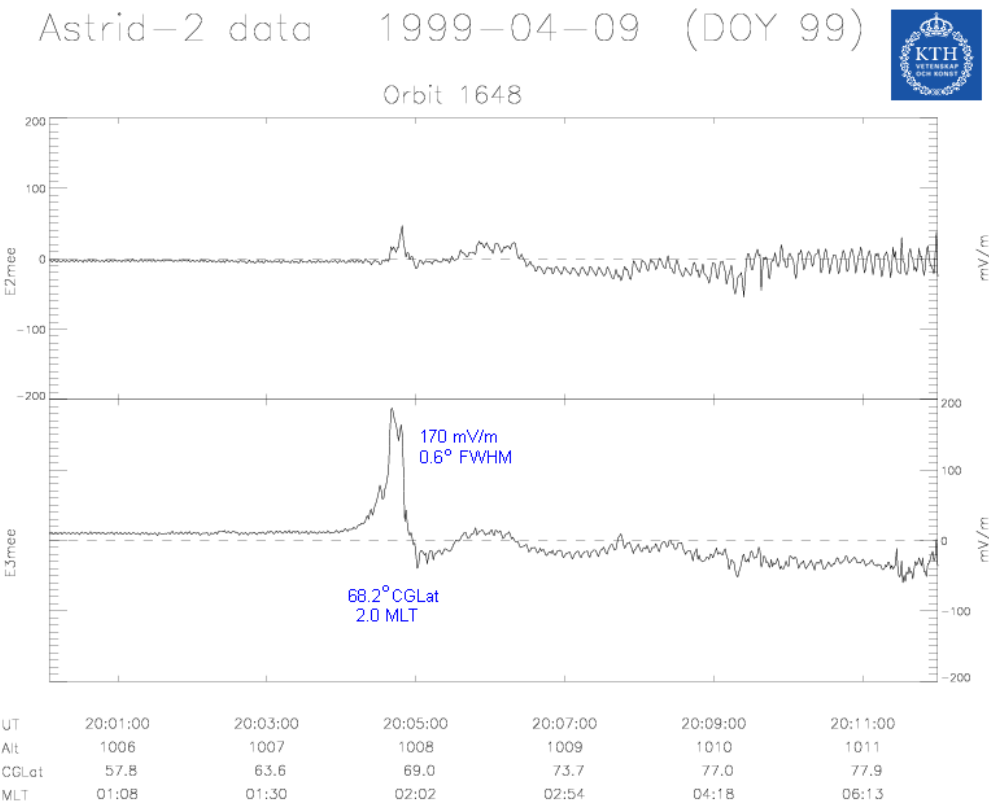
Fig. 3. Eastward and equatorward electric field components (panels 1 and 2, respectively) measured on 9 April 1999 between 20:00 and